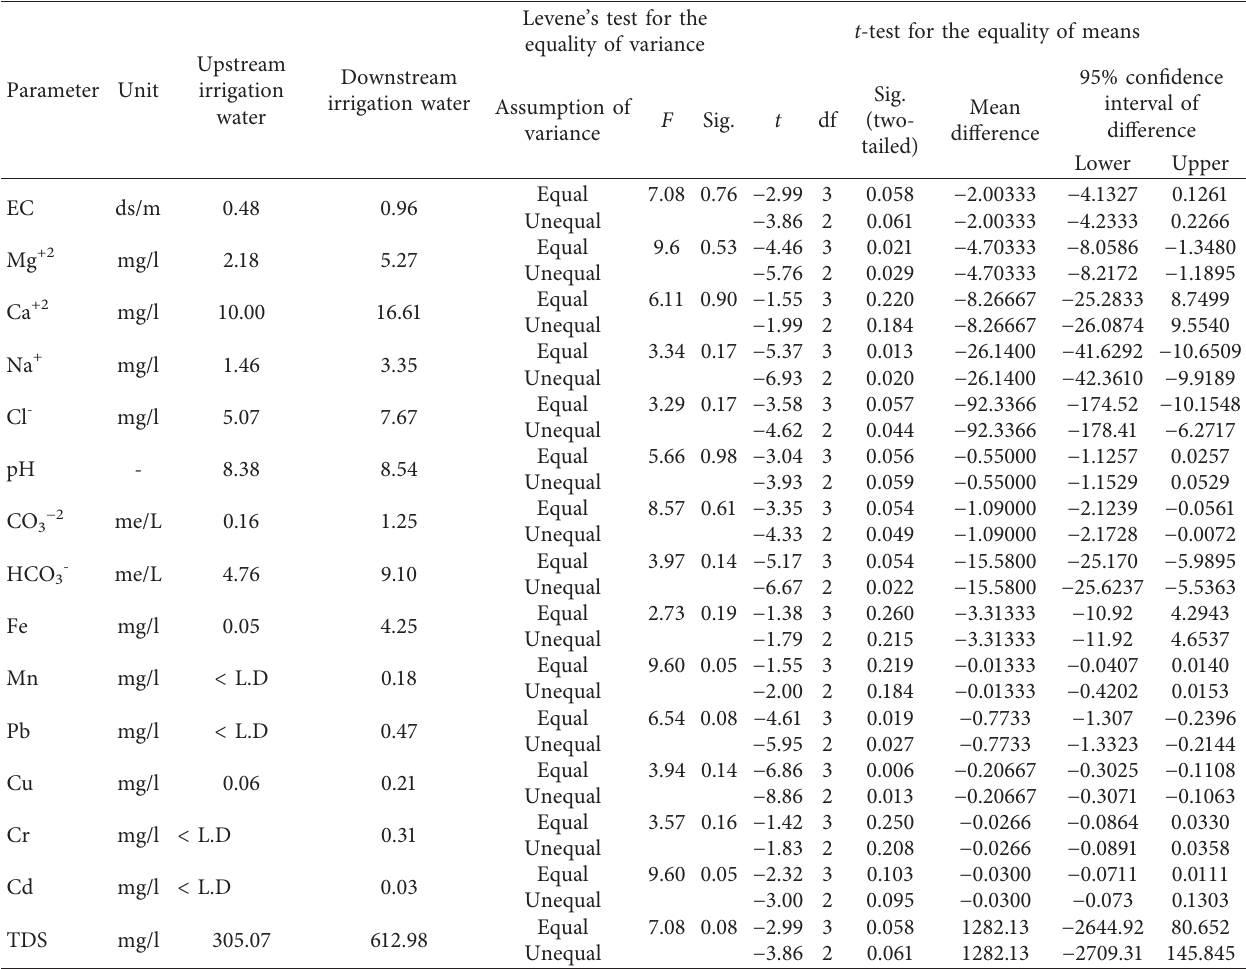
Table 5: Independent sample t -test for the upstream and downstream Borkena irrigation